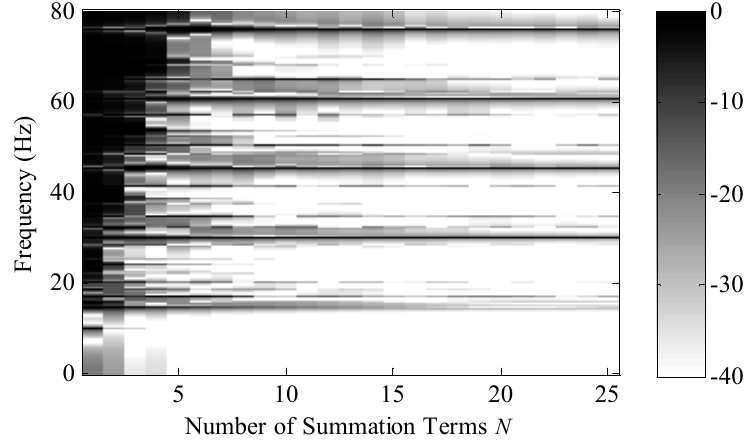
7 of 16 Figure 2. Displacement versus frequency for a rod with a linear variation of cross-sectional area. The solid line is the series solution, the circular markers are the analytical solution and the dashed line is